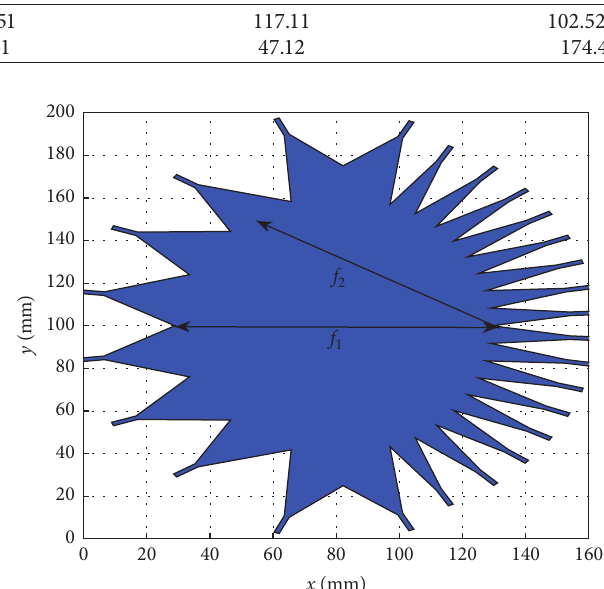
Figure 21: Geometry of the X-band Rotman